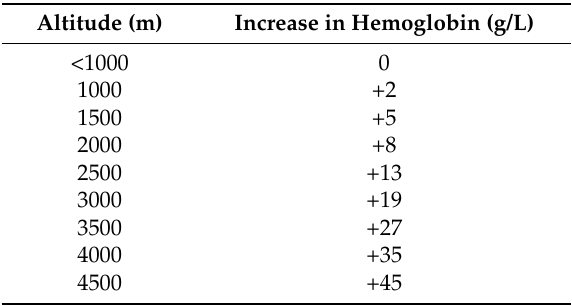
Table 2. Normal increases of hemoglobin values related to long-term altitude exposure.